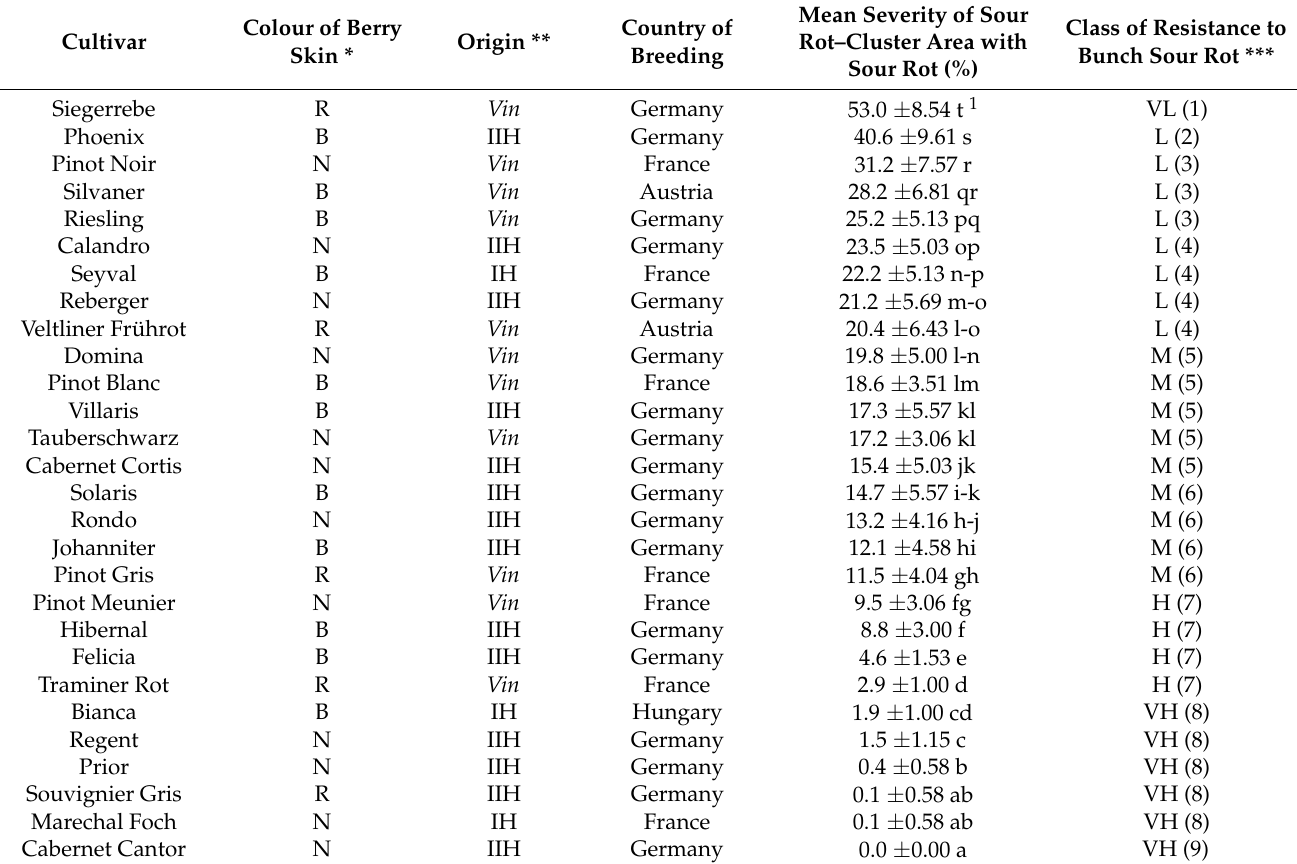
Table 2. Severity of infestation and resistance of wine cultivars to sour bunch rot.